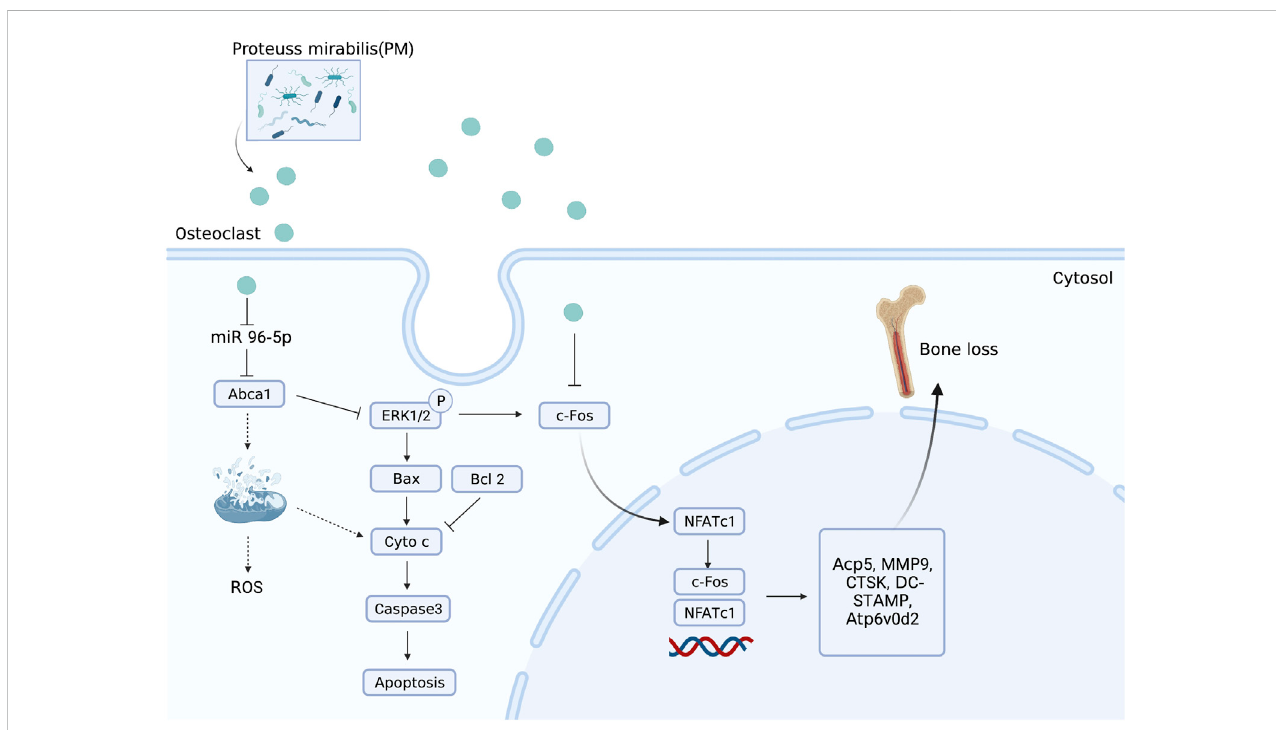
FIGURE 3 BEVs produced from Proteus mirabilis alleviate bone loss in OP. Administration of PM-derived BEVs reduced bone loss in OVX-induced OP mice via the regulation of miR-96-5p/Abca1